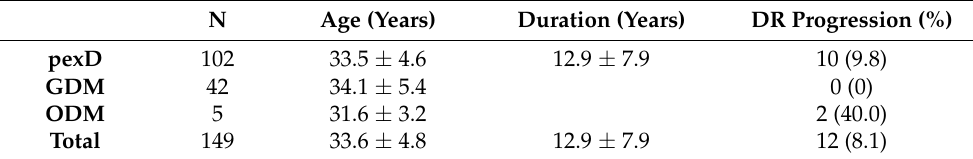
Table 4. DR progression ratio from multicenter